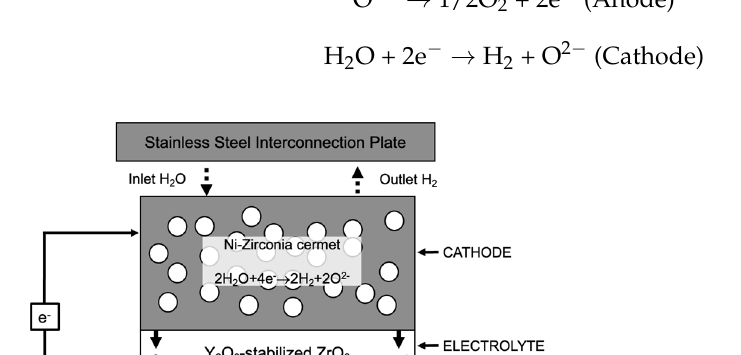
Figure 4. Scheme for HTEL, high-temperature solid oxide electrolysis. Reprinted with permission from [23].